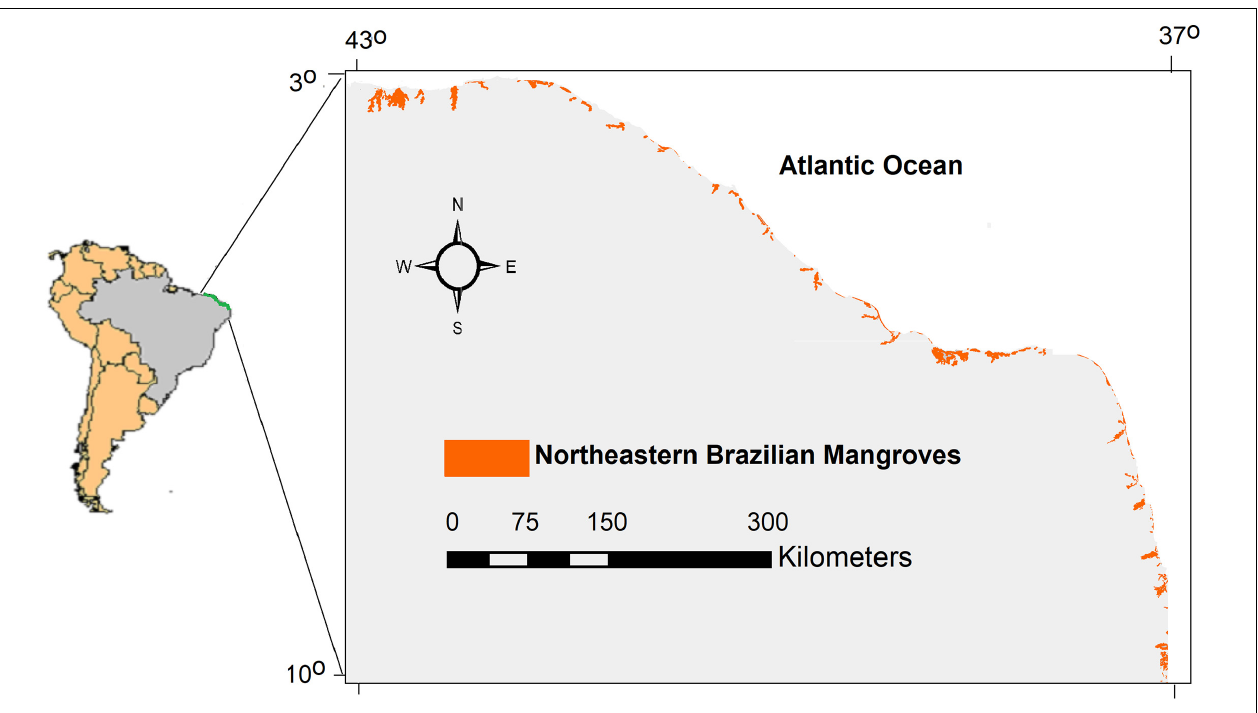
FIGURE 1 | Distribution of mangroves along the Northeast of Brazil. Mangroves of the semiarid coast, where most aquaculture is established, are shown in red. Map modified from Maia et al. (2006), Instituto Chico Mendes de Conservação da Biodiversidade [ICMBio]